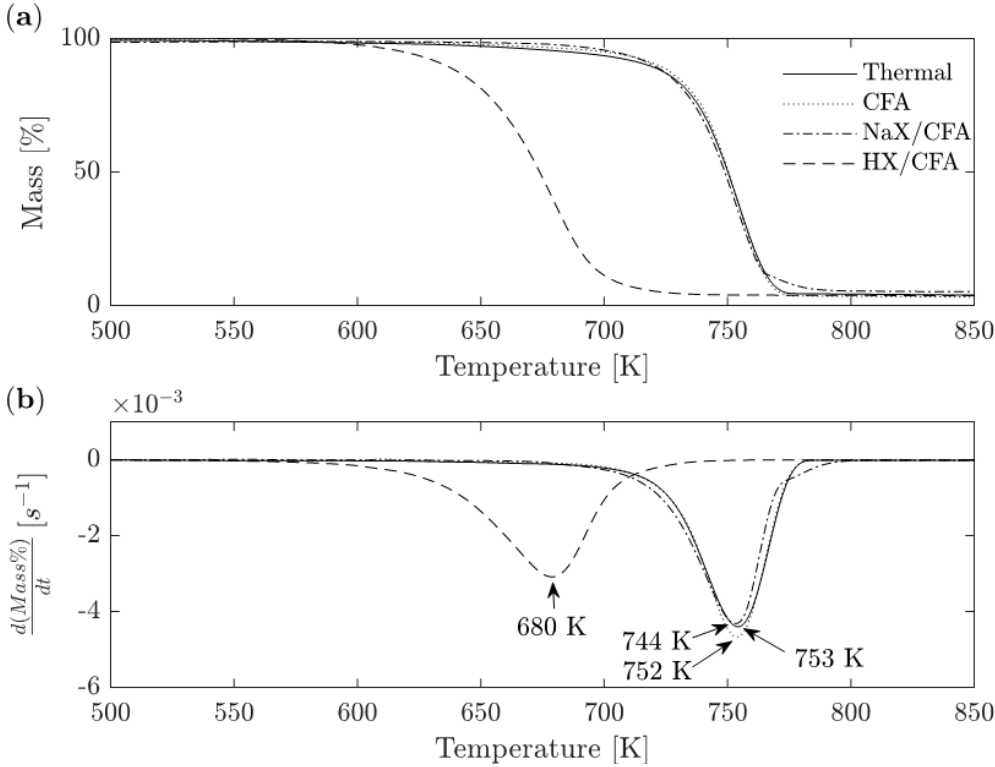
Figure 1. ( a ) TG and ( b ) DTG curves describing thermal and catalytic (CFA, NaX/CFA, HX/CFA) degradation of PFR (thermal experiment comes from Ippolito et al. [28]).